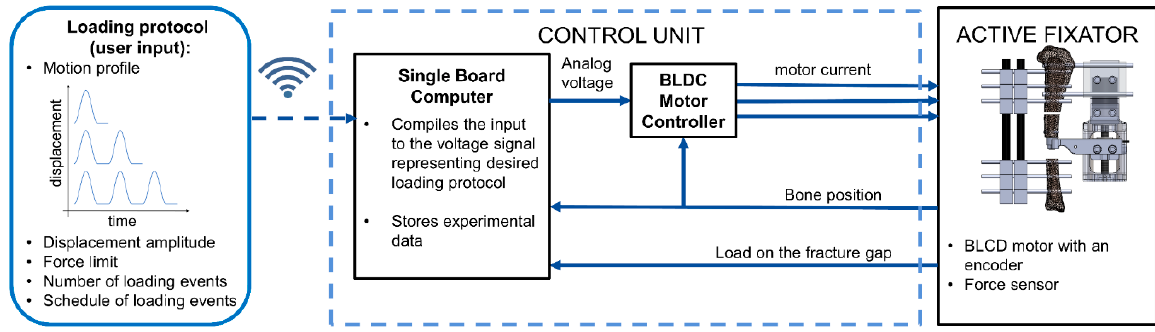
Figure 2. The principle of operation and flow of signals in the control unit.